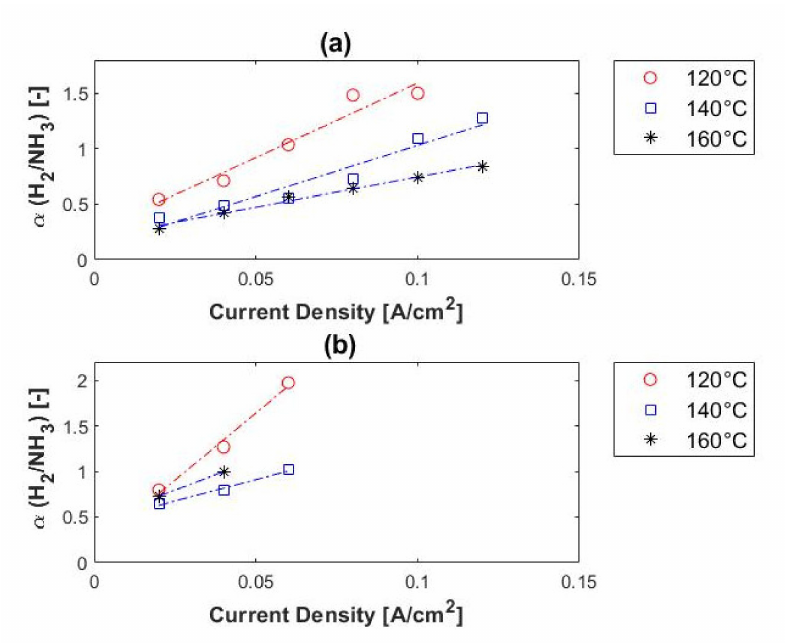
Figure 15. H 2 /NH 3 selectivity, in terms of ammonia concentration, versus current density: ( a ) 1500 ppm and ( b ) 3000 ppm ammonia, balance hydrogen (hydrogen flow rate = 100 mL n /min, 1